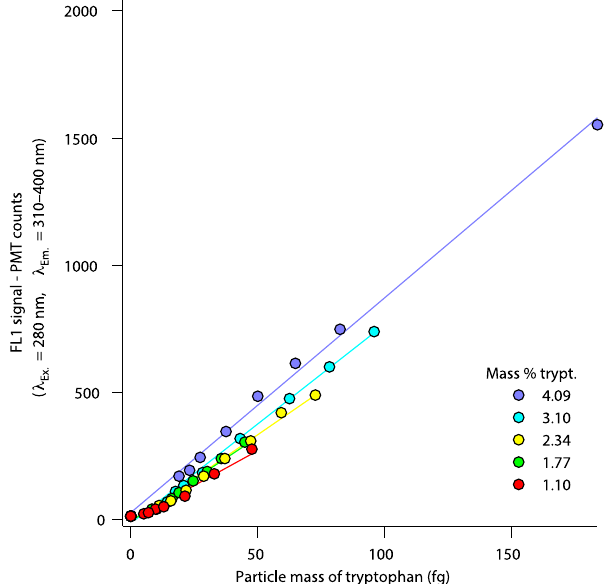
Figure 7. Fluorescence response to size-selected mixed particles containing tryptophan and ammonium sulfate at different mass ra- tios. These calibration curves were taken at a lower gain setting than either of the curves in Fig. 4a and thus should not be directly com- pared.